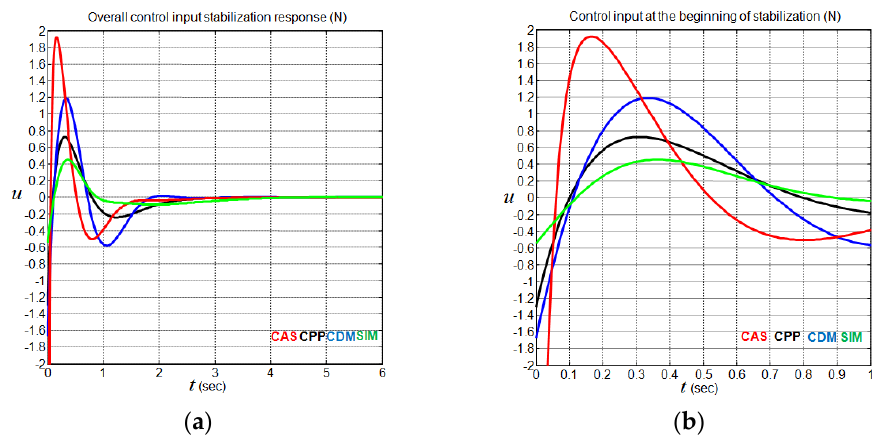
Figure 13. CIP input responses using CAS, CPP, CDM, and SIM methods. ( a ) Overall input re- sponses; ( b ) restricted input responses. ( b ) restricted input Table 5. Controller performance comparison using nonlinear CIP model.